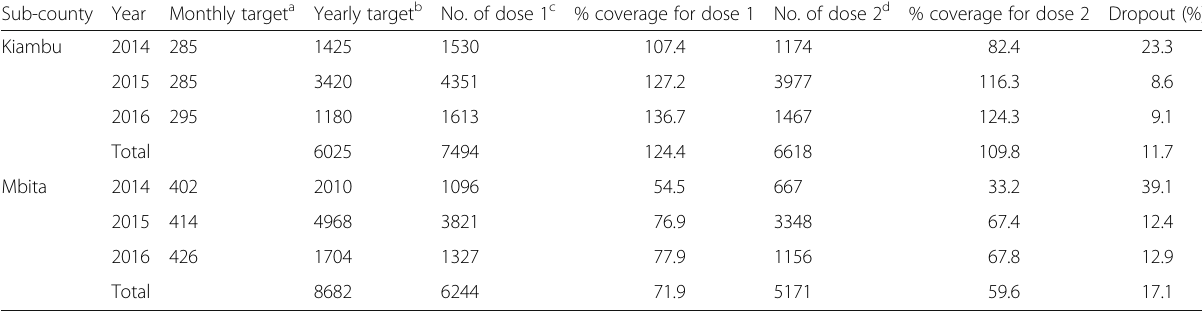
Table 1 Rotavirus vaccine targets, doses administered, and coverage in Kiambu and Mbita sub-counties, August 2014 – April